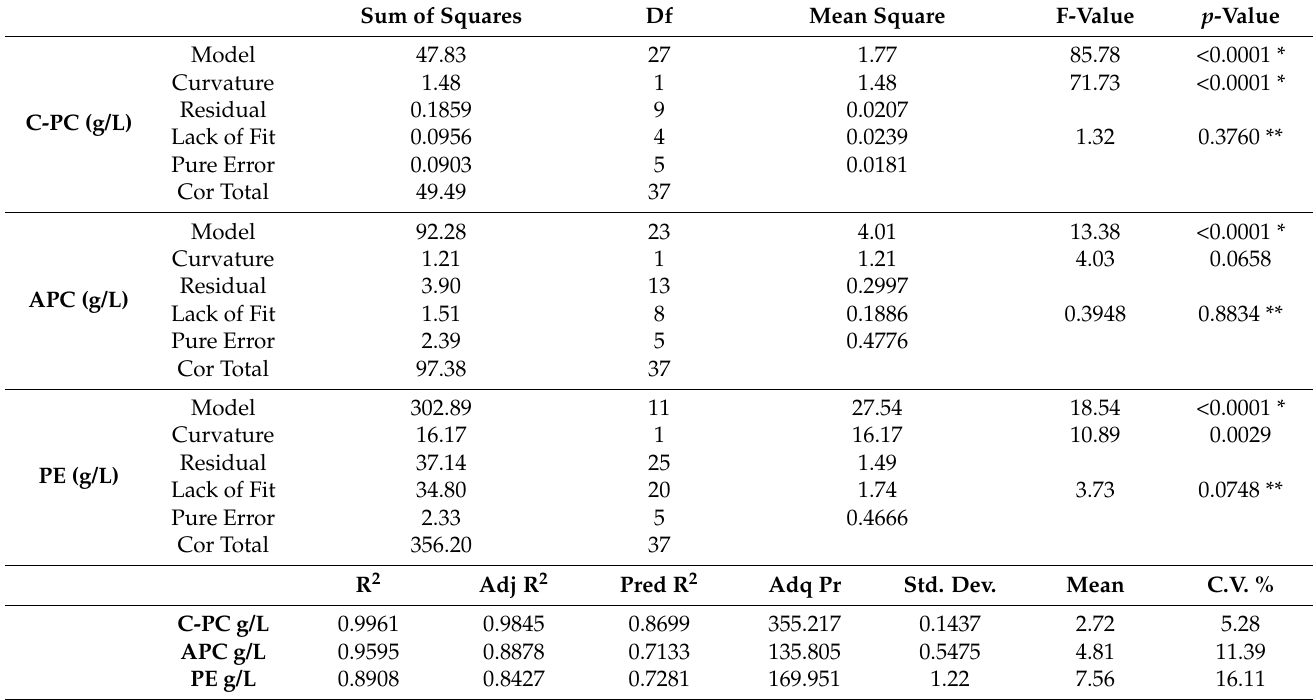
Table 2. Analysis of variance (ANOVA) of the model obtained for C-PC, APC, and PE extraction. Sum of Squares Df Mean Square F-Value p